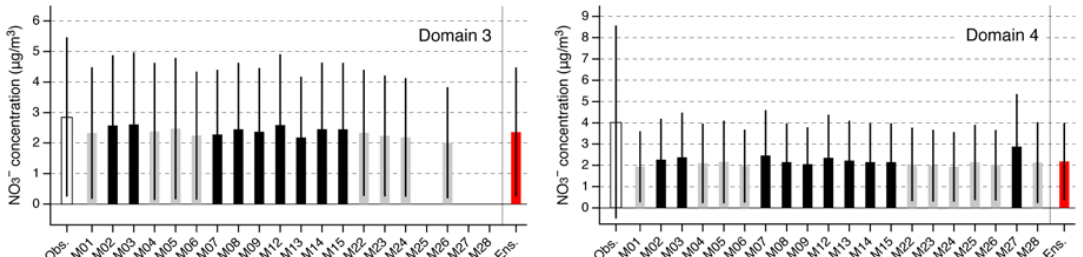
Figure 3. NO 3 − concentration averaged during winter over (left) domain 3 across 24 APMSs and (right) domain 4 across 25 APMSs. The total evaluation number was 335 (24 APMSs with available observation number during 2 weeks of intensive observations) over domain 3 and 338 (25 APMSs with available observation number during 2 weeks of intensive observations) over domain 4. Whiskers show the standard deviation for the data. White bars are the observations at APMSs, and the black, grey, and red bars are the model results. Black indicates models that used a di ff erent external dataset, grey represents models that used the common dataset (see also Table 1), and red represents the ensemble mean.